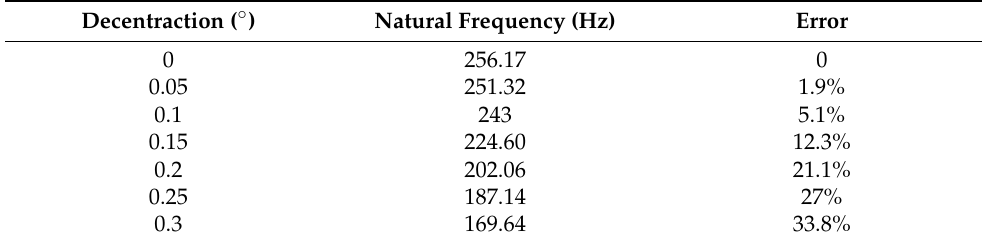
Table 6. The change rate of the natural frequency of the 3rd order.